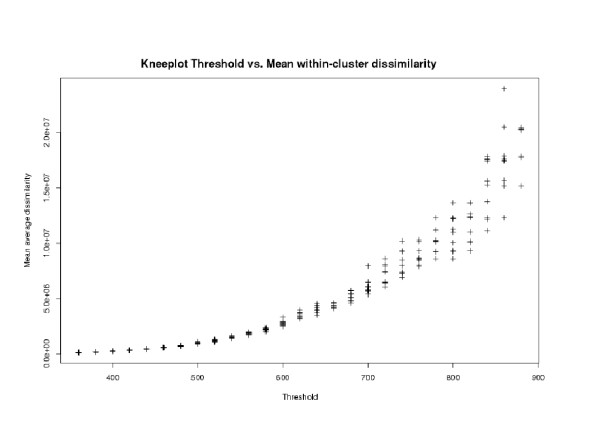
Kneeplot of the mean average dissimilarity across varying thresholds for the leader clustering algorithm. The mean average dissimilarity is computed as 1K∑k=1K1|Ck|∑i∈Ck∑i'∈Ckdi,i'
 MathType@MTEF@5@5@+=feaafiart1ev1aaatCvAUfKttLearuWrP9MDH5MBPbIqV92AaeXatLxBI9gBaebbnrfifHhDYfgasaacH8akY=wiFfYdH8Gipec8Eeeu0xXdbba9frFj0=OqFfea0dXdd9vqai=hGuQ8kuc9pgc9s8qqaq=dirpe0xb9q8qiLsFr0=vr0=vr0dc8meaabaqaciaacaGaaeqabaqabeGadaaakeaadaWcaaqaaiabigdaXaqaaiabdUealbaadaaeWaqaamaalaaabaGaeGymaedabaWaaqWaaeaacqWGdbWqdaWgaaWcbaGaem4AaSgabeaaaOGaay5bSlaawIa7aaaaaSqaaiabdUgaRjabg2da9iabigdaXaqaaiabdUealbqdcqGHris5aOWaaabmaeaadaaeWaqaaiabdsgaKnaaBaaaleaacqWGPbqAcqGGSaalcqWGPbqAcqGGNaWjaeqaaaqaaiabdMgaPjabcEcaNiabgIGiolabdoeadnaaBaaameaacqWGRbWAaeqaaaWcbaaaniabggHiLdaaleaacqWGPbqAcqGHiiIZcqWGdbWqdaWgaaadbaGaem4AaSgabeaaaSqaaaqdcqGHris5aaaa@51D3@, with Ck being the data points in cluster k, and K being the total number of clusters. As the result of the leader algorithm depends on the input order of the data, the clustering procedure is repeated ten times with shuffled input.